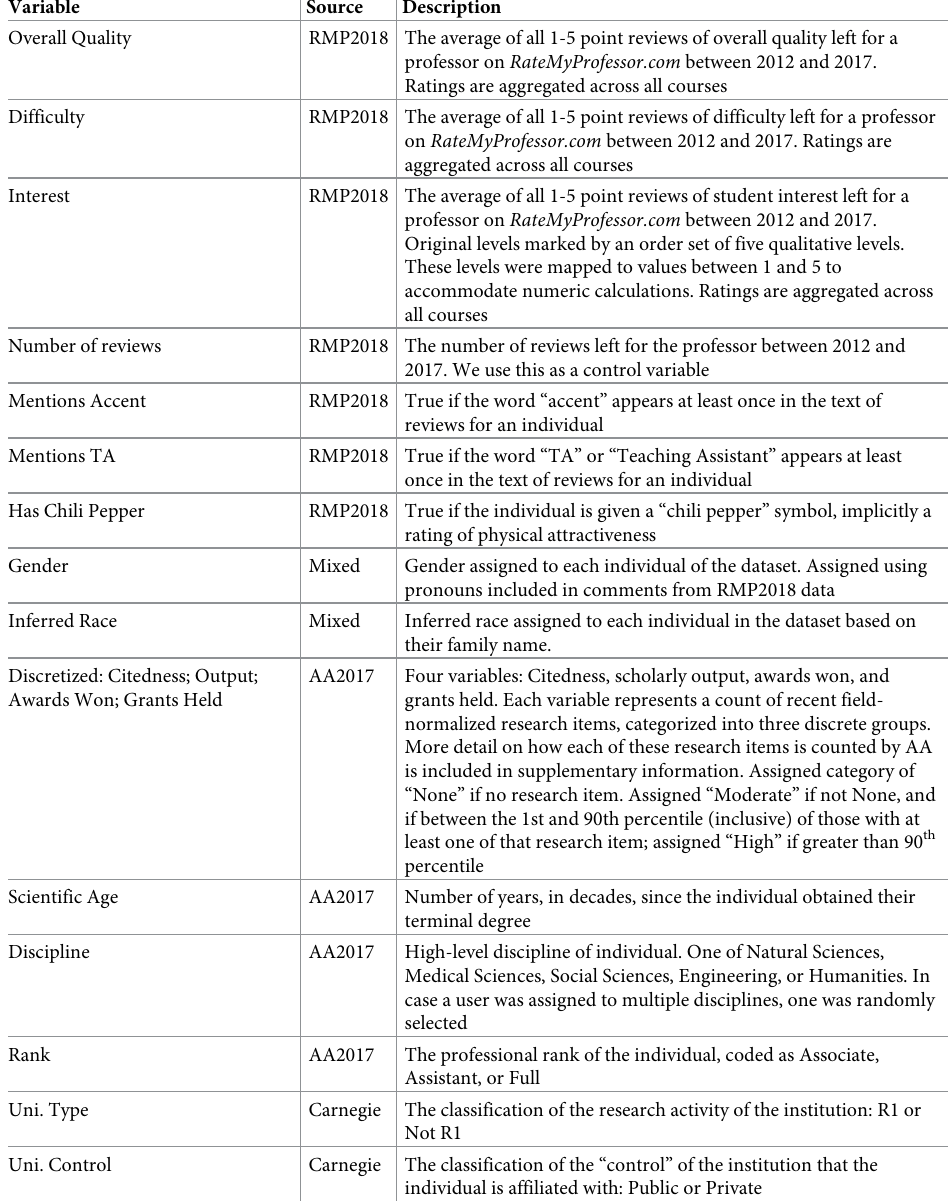
Table 1. Description of final variables. Extracted from RateMyProfessor.com (RMP2018), the 2017 version of Aca- demic Analytics (AA2017), and the Carnegie Classification of Higher Education Institutions (Carnegie) for matched profiles.